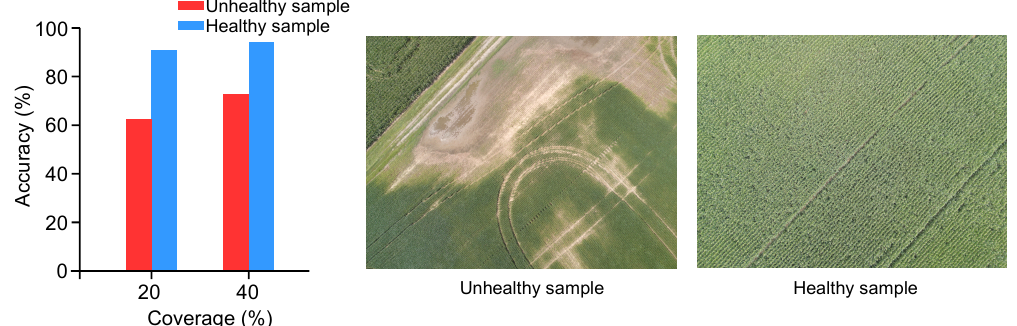
Figure 7. Accuracy of whole-field RL at 20% and 40% coverage rates for largely healthy and largely unhealthy